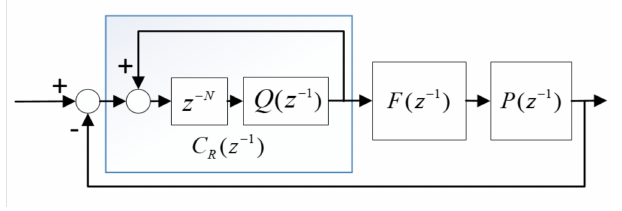
Figure 7. Block diagram of the repetitive